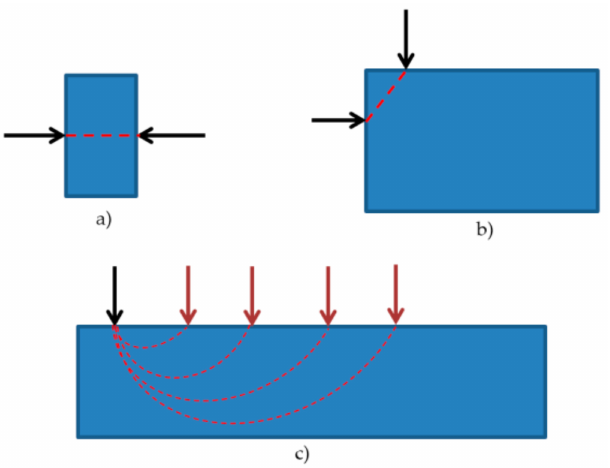
Figure 12. Wave velocity measurement—ultrasonic testing schema: ( a ) crosswise method; ( b ) semi- direct method; ( c ) surface